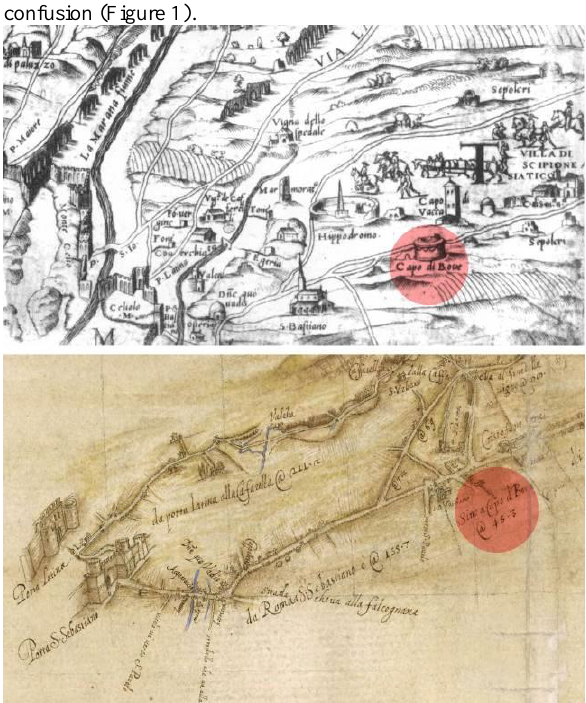
Figure 1. The first representations of the Roman Agro, above Eufrosino della Volpaia (1547), Catasto Alessandrino (1660). Identification of locality Capo di